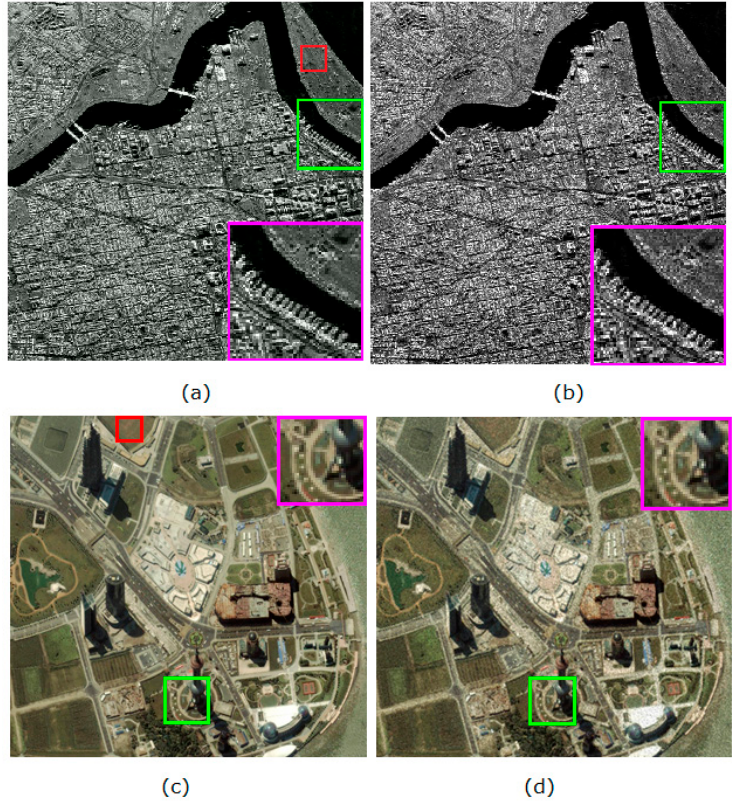
Figure 8. The single-look image and the corresponding multi-look references. ( a ) Grayscale multilook reference; ( b ) Grayscale single-look image; ( c ) Color multi-look reference; ( d ) Color single-look image.